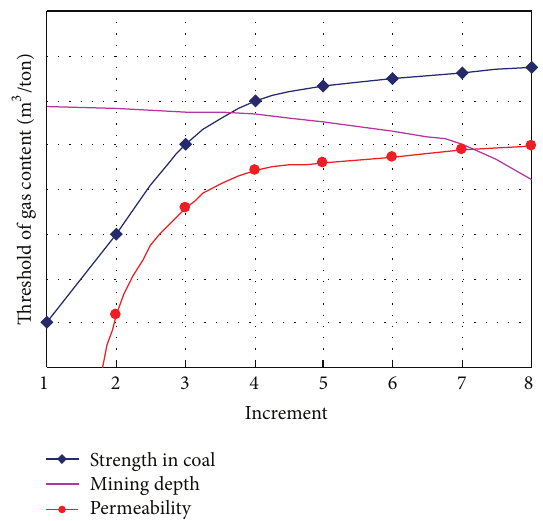
Figure 9: Major parameters affecting the initiation of outbursts of coal and gas [15].